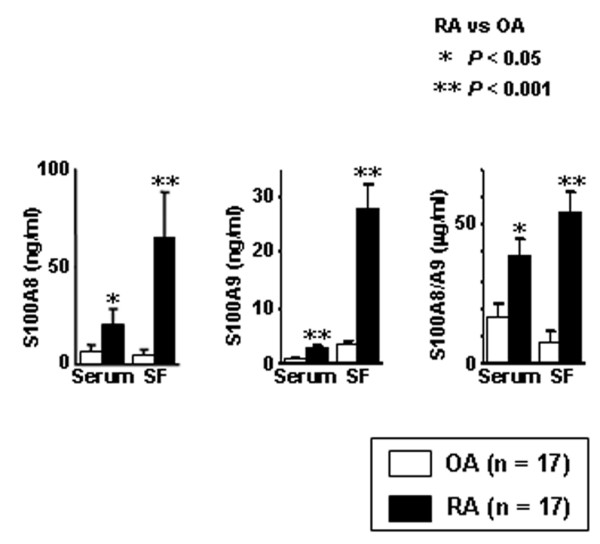
Concentrations of S100A8 and S100A9 proteins in the serum and synovial fluid (SF) of rheumatoid arthritis (RA) and osteoarthritis (OA). Paired serum and SF samples were prepared from patients with RA and patients with OA. Concentrations of the S100A8 and S100A9 homodimer and the S100A8/A9 heterodimer were measured in duplicate by enzyme-linked immunosorbent assay. Values are the mean ± standard error of the mean. n, number of samples tested.